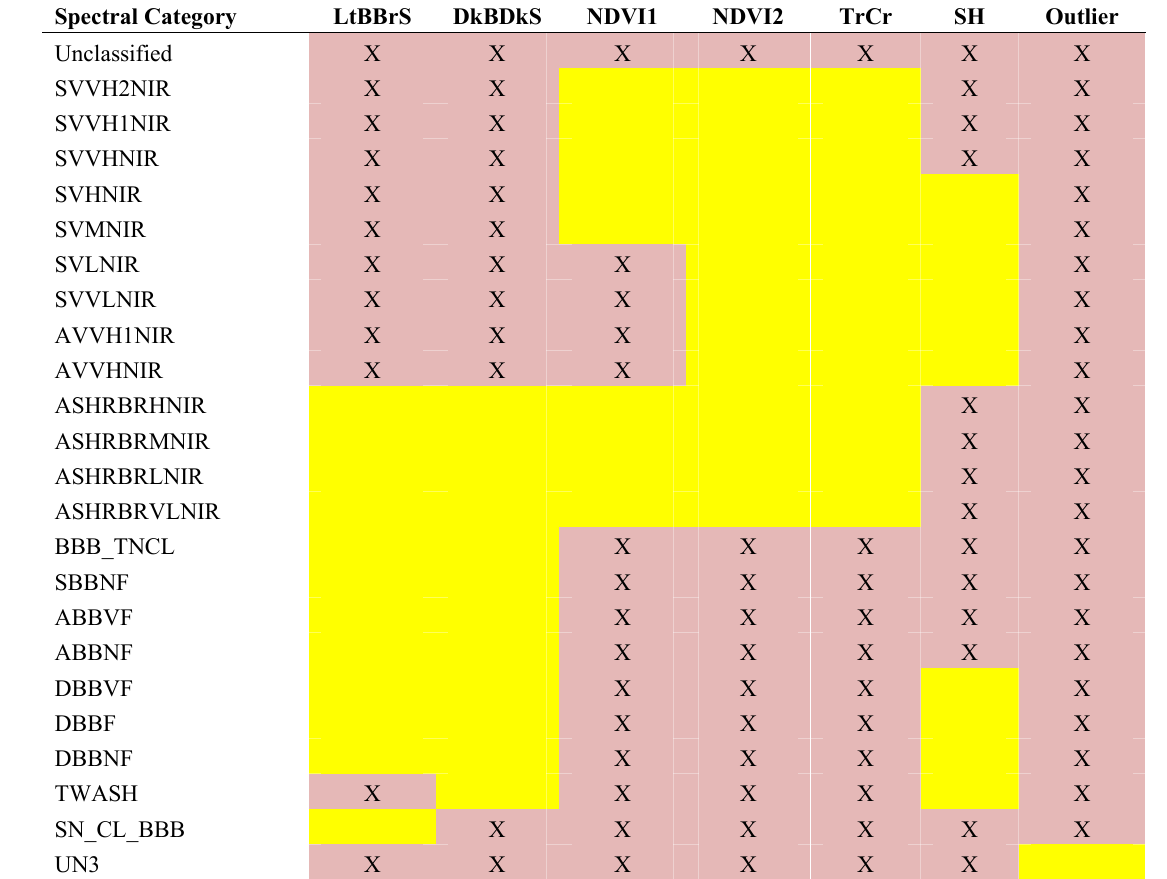
Table 13. Fine-granularity Q-SIAM™ pre-classification of the Leica test image. OAMTRX instance between test classes (refer to Table 4) and reference classes (refer to Table 7), represented as table rows and columns respectively. For the sake of simplicity, only test classes (table rows) whose occurrence is greater than 0.15% in the test map being investigated are shown. “Correct” entries selected by the present authors for inter-vocabulary reconciliation are shown as yellow